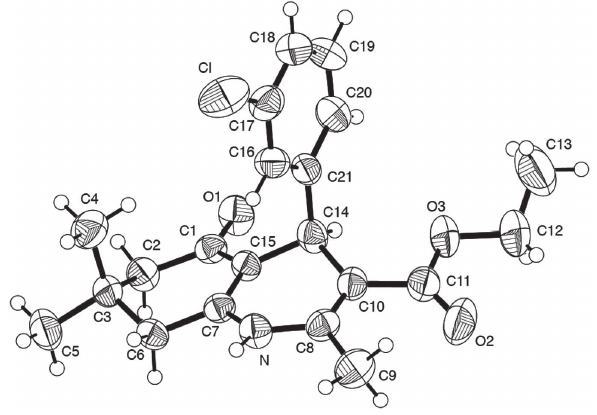
Table 2: Fractional atomic coordinates and isotropic or equivalent isotropic displacement parameters (Å 2